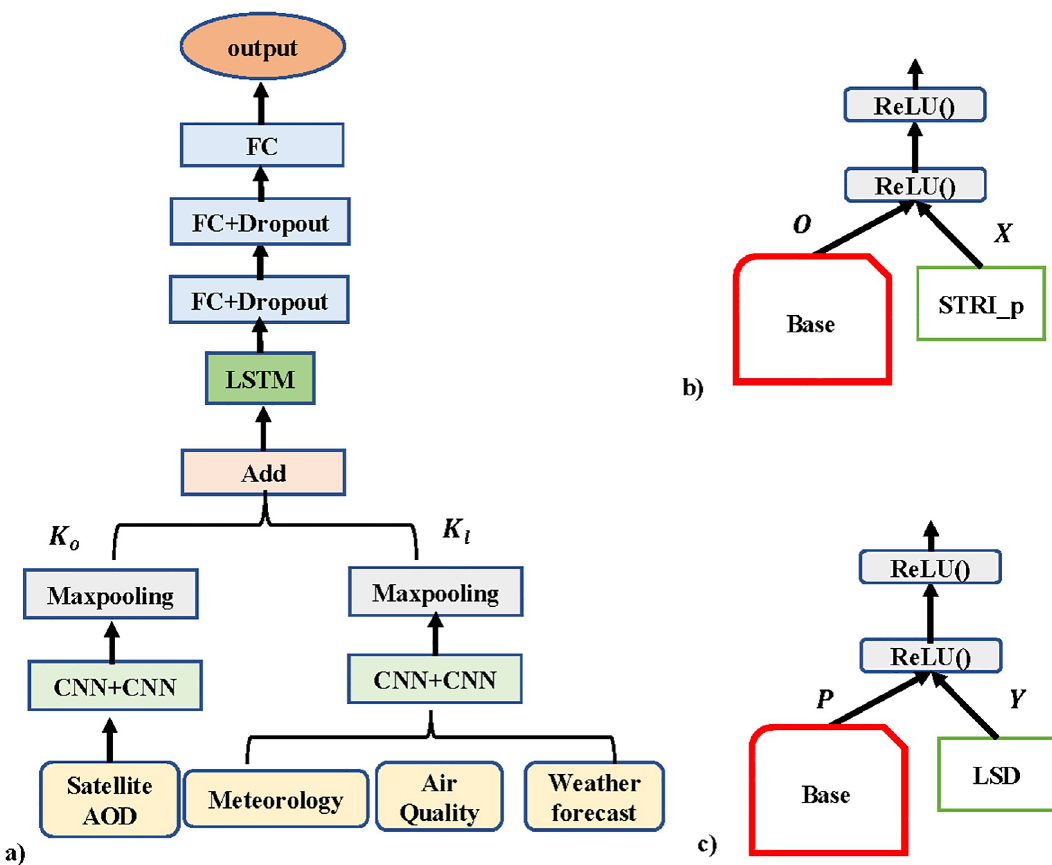
Fig 4. LSD, RTP and ESD models. (a) Structure of LSD model, (b) RTP model, and (c) ESD